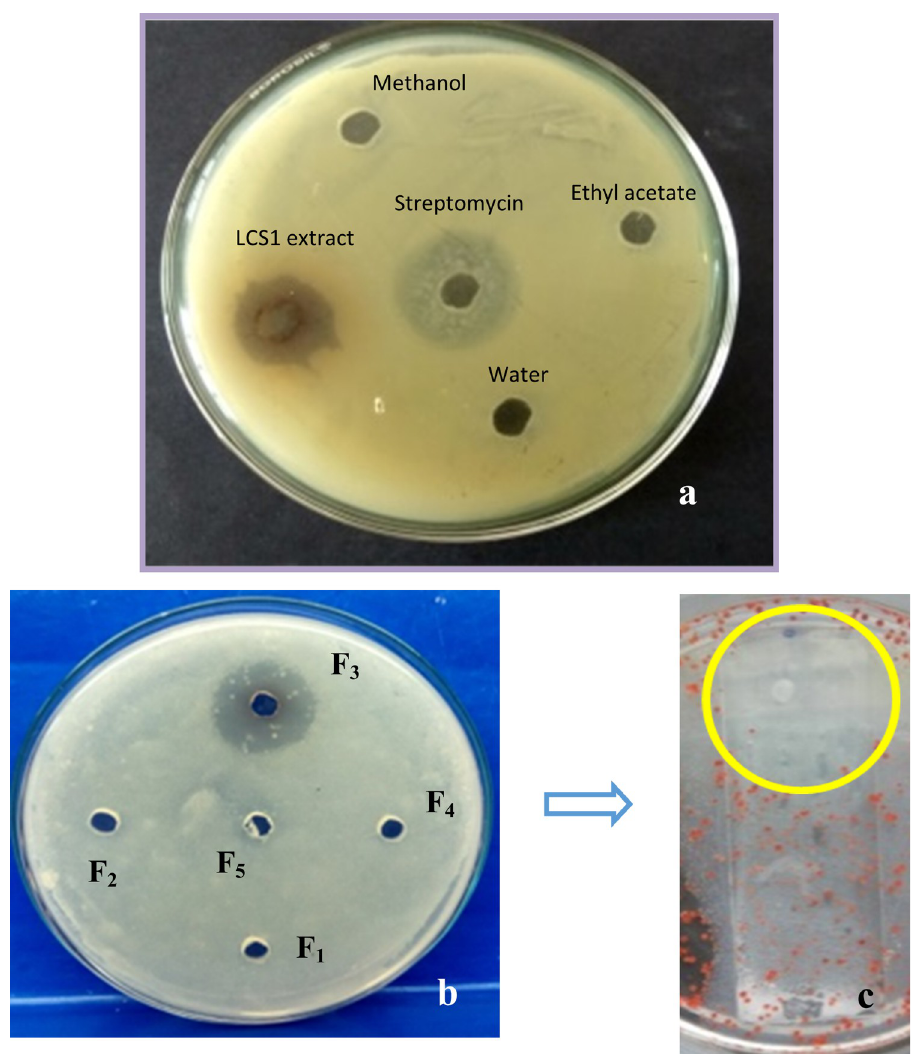
Fig 2. a- Antibacterial activity of the LCS1 culture extract (31.25 μ g/mL) against MRSA in a nutrient agar medium. b- Antibacterial action of the F3 (fraction 3) with highest clear zone of inhibition. c- Clear zone of inhibition of bacterial (MRSA) growth on TLC plate after TTC